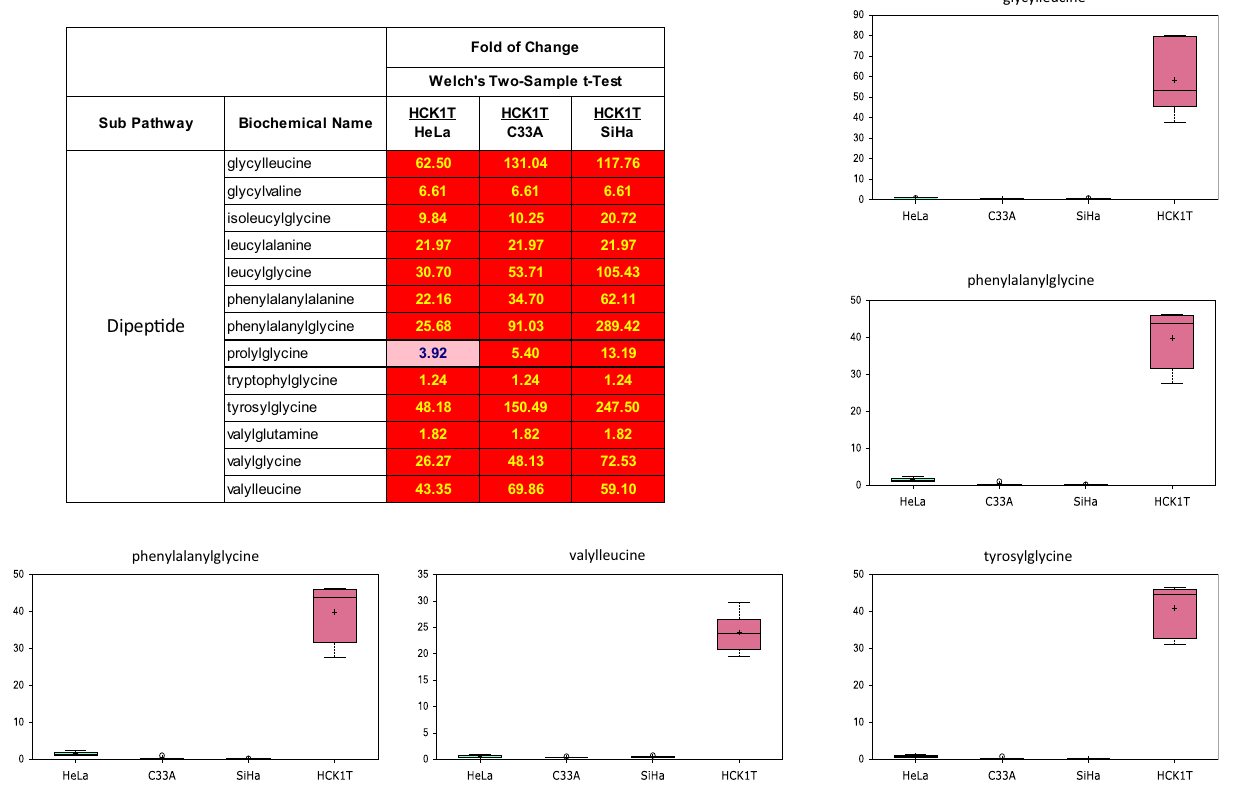
Figure 8. Documentation of elevated levels of many dipeptides exhibited exclusively by the normal HCK1T cells. Dipeptides levels are shown as box plots. Each box plot provides a measure of scaled intensity, normalised by protein content. A heat map, with the major biochemical changes is also shown. For the color key of the heat map, see the legend of Fig.